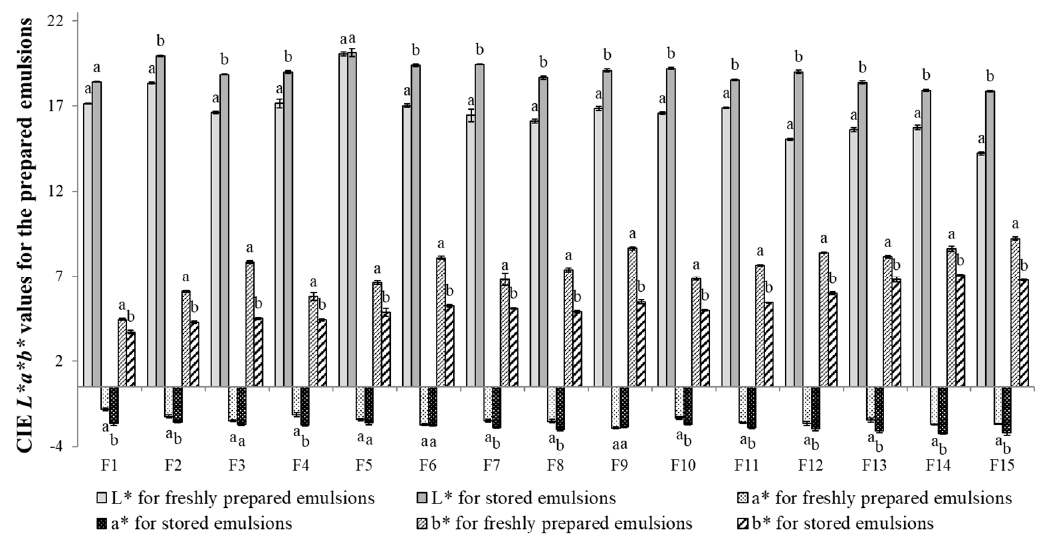
Figure 2. CIE L*a*b* values for the prepared emulsions. a, b—different letters for the same parameter for freshly prepared and stored emulsions indicate significantly different values ( p < 0.05).